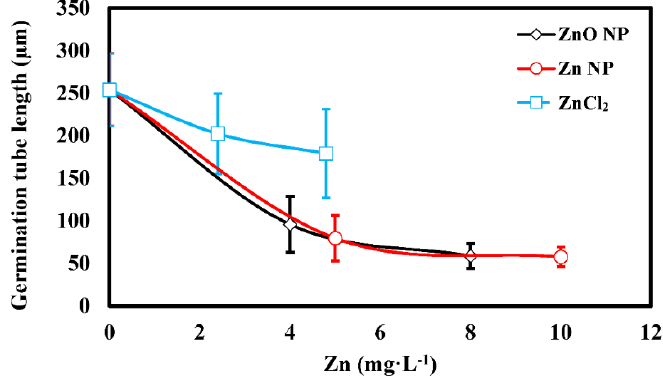
Figure 5. Spore germination tube length as measured for selected treatments. Error bars = standard deviation.